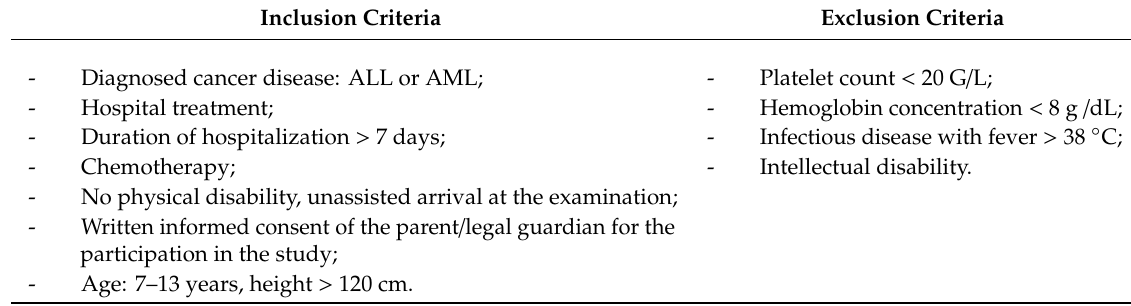
Table 3. Inclusion and exclusion criteria in the study